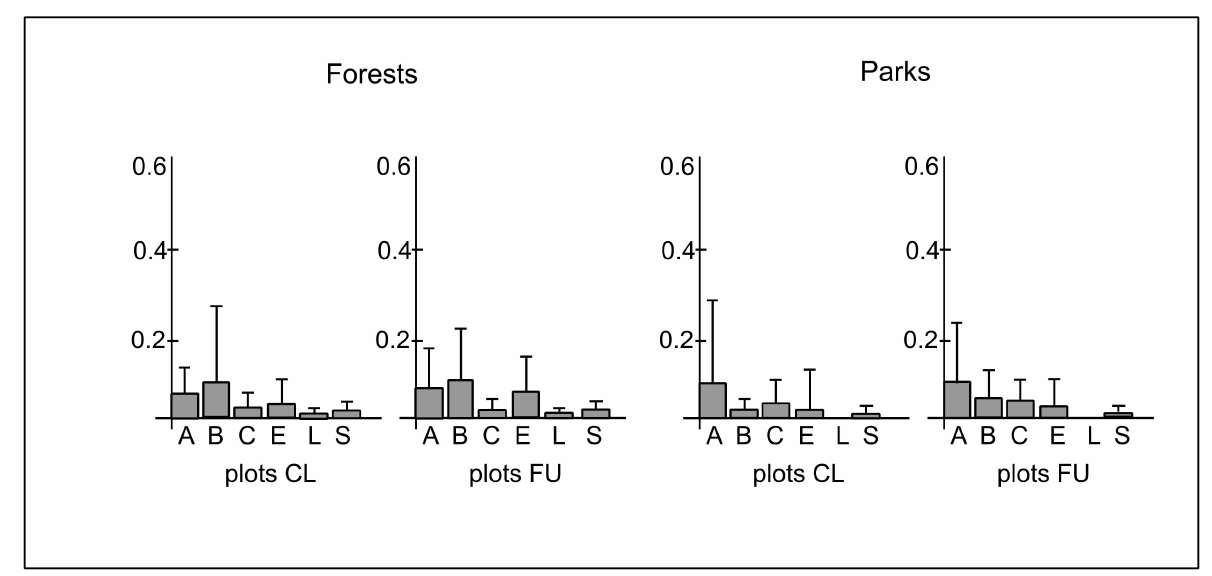
Figure 6. The mean (boxes) and standard deviation (whiskers) values of cover-abundance degree of species representing different dispersal types (A— Allium , B— Bidens , C— Cornus , E— Epilobium , L— Lycopodium , S— Sparganium ) per plot in closer (CL) and further (FU) plots located along paths in forests and parks.